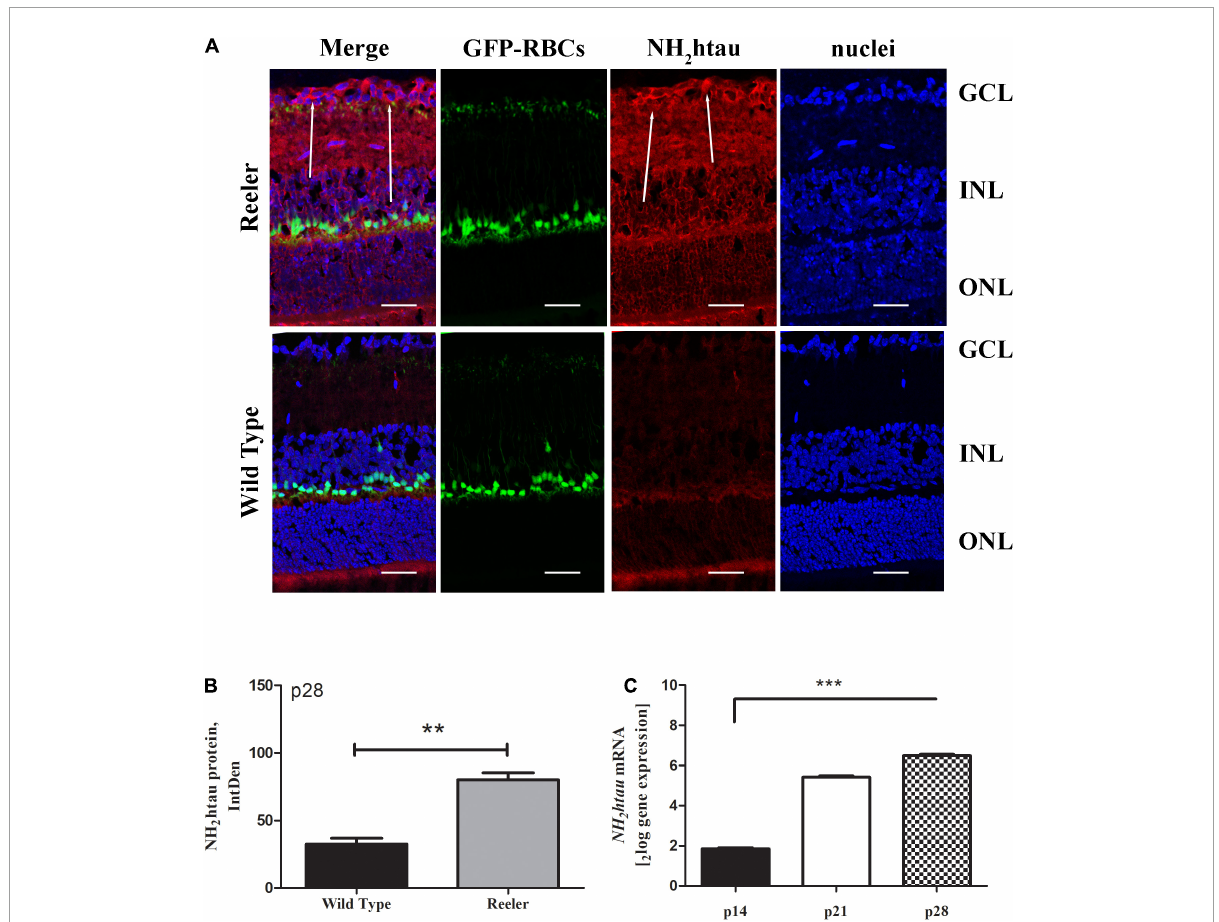
FIGURE3 The NH 2 htau expression in Reeler retinas. (A) Representative confocal fluorescence microscopy images (p28) showing NH 2 htau immunoreactivity and GFP-expressing RBCs (merge; green/red) over a nuclear staining (dapi/blue), and single-channel acquisitions (t-NH 2 htau/red; GFP-expressing RBCs/green; dapi/blue). White arrows point to a noticeable staining of NH 2 htau (red) at the GCL of Reeler retinas. (B) Histogram representative of NH 2 htau IntDen analysis in both Reeler and WT retinas (p28). Note the increased expression of NH 2 htau protein (mean ± SEM) in Reeler mice with respect to WT ( n = 3 optic fields per slide of 3 animals per group; ** p < 0.01, Kruskal Wallis analysis with post Dunn’s multiple comparison test analysis). (C) Retina extracts confirmed the presence of tau transcript starting from p21 (*** p < 0.0001, REST analysis). NH 2 htau, truncated tau; GFP, Green Fluorescent Protein; RBCs, Rod Bipolar Cells; GCL, Ganglion Cell Layer; INL, Inner Nuclear Layer; ONL, Outer Nuclear Layer; IntDen, Integrated Optical Densitometry. Magnifications: × 40; white bar: 20 µ m.